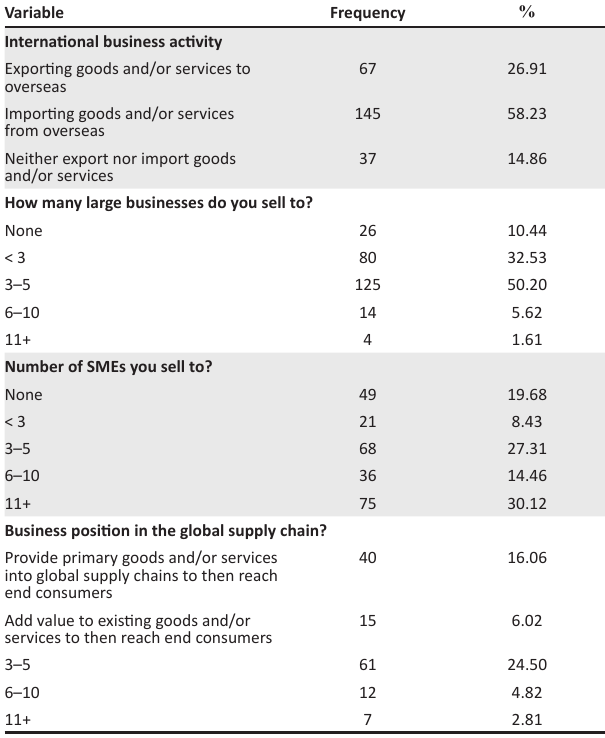
TABLE 1: Descriptive statistics. TABLE 2a: Small and medium enterprise supply chain and Fourth Industrial Revolution technology adoption.